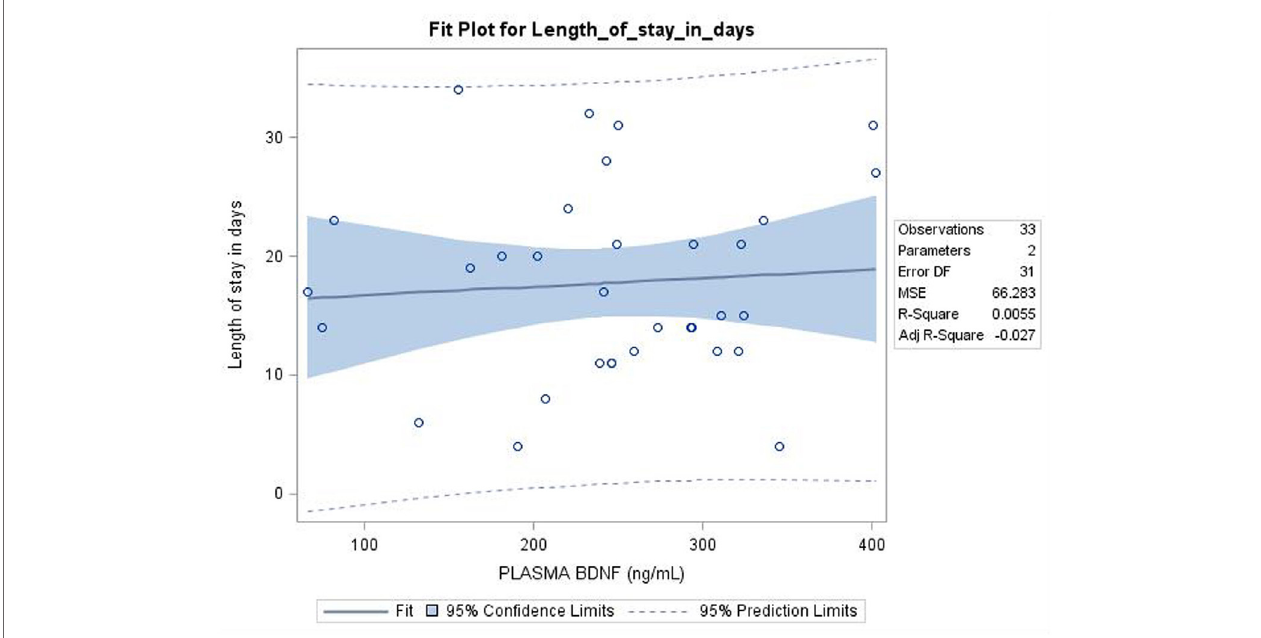
FigUre 2 | Pearson correlation showed no relation between Plasma Brain derived neurotrophic factor (BDNF) level (ng/ml) and length of stay among neonatal abstinence syndrome infants; p =